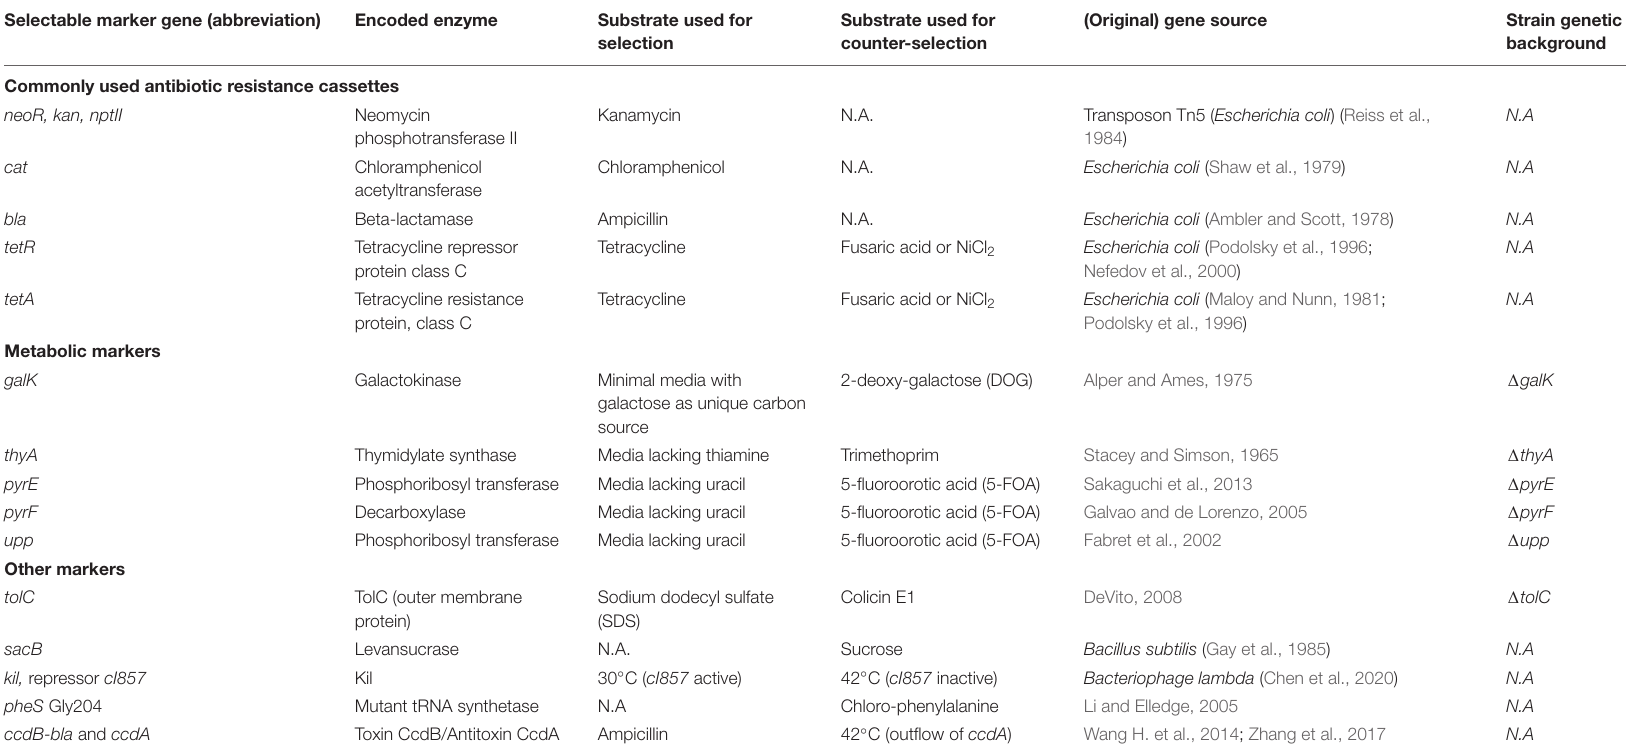
Substrate used for (Original) gene source Strain genetic selection counter-selection